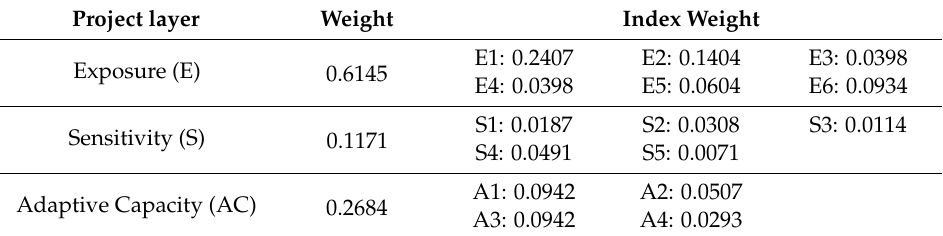
Table 2. AHP weights for atmospheric environment vulnerability assessment